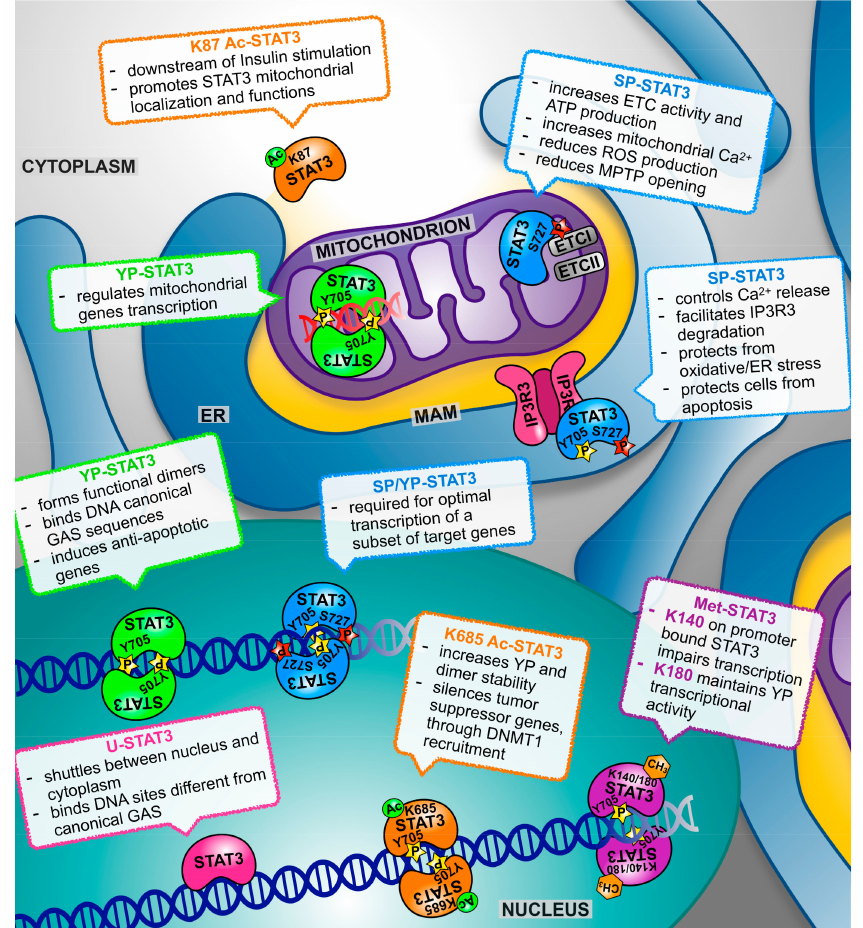
Figure 1. The scheme depicts the multiple roles of signal transducer and activator of transcription (STAT)3 according to its post-translational modifications and subcellular localization. See text for details and references. YP—tyrosine-phosphorylated (YP)-STATs; SP—serine